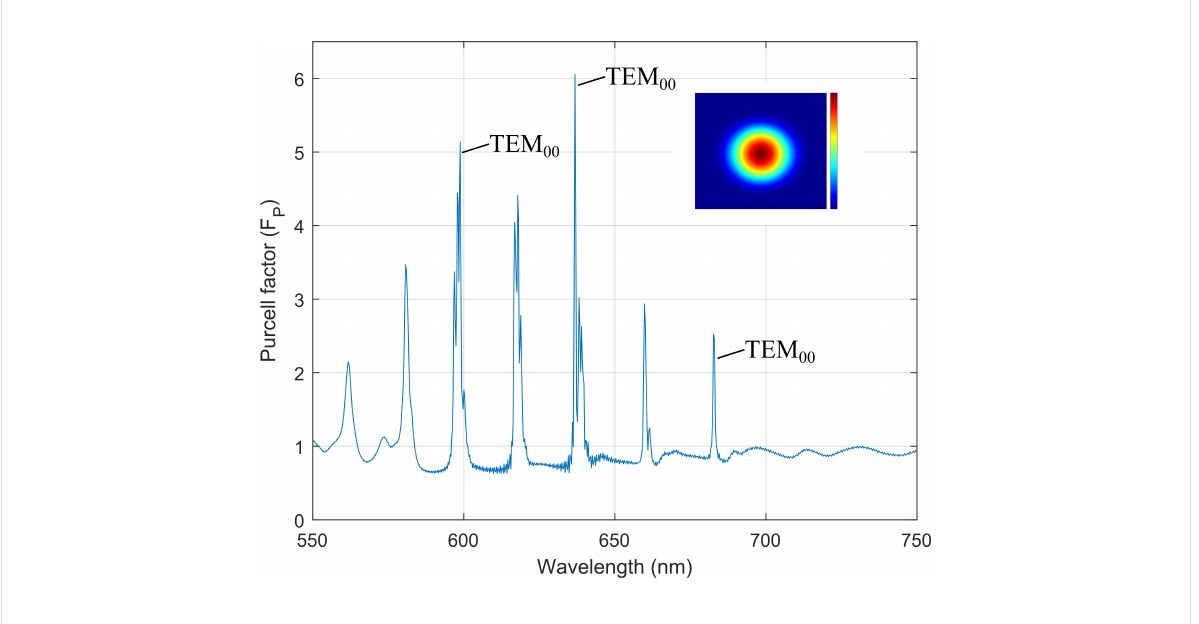
Figure 8: Purcell factor of plano-concave microcavity. Fundamental TEM Gaussian modes are found at 595 nm, 636 nm and 684 nm. Inset shows transverse section of fundamental Gaussian mode at 637